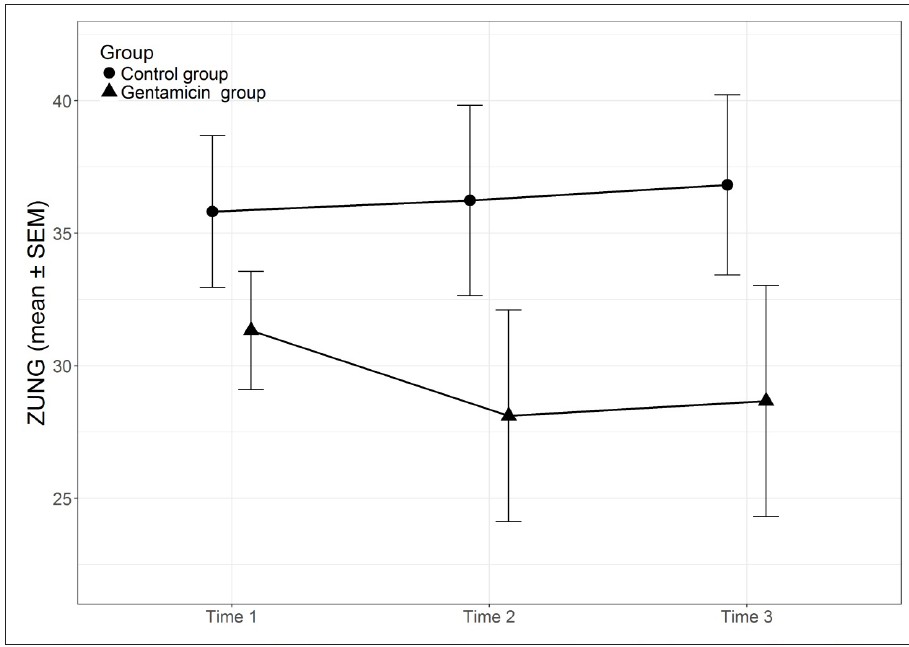
Fig. 2. Changes of the results from the ZUNG questionnaire (mean ± standard error of mean) in the gentamicin and the control groups during the study period. Time 1: 2 months before surgery, time 2: 2 weeks before surgery, after pretreatment in the genta- micin group, time 3: 3 months after surgery ( P